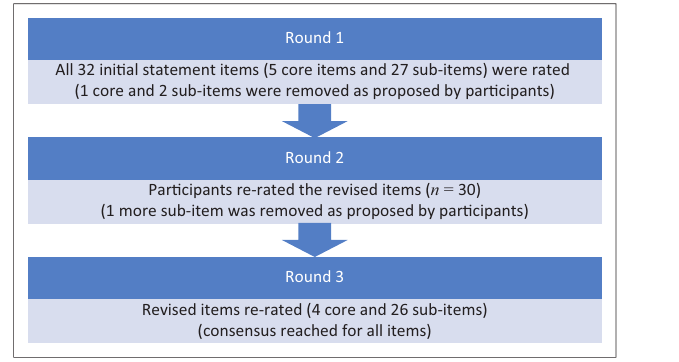
FIGURE 1: Flow diagram to show the Delphi three survey